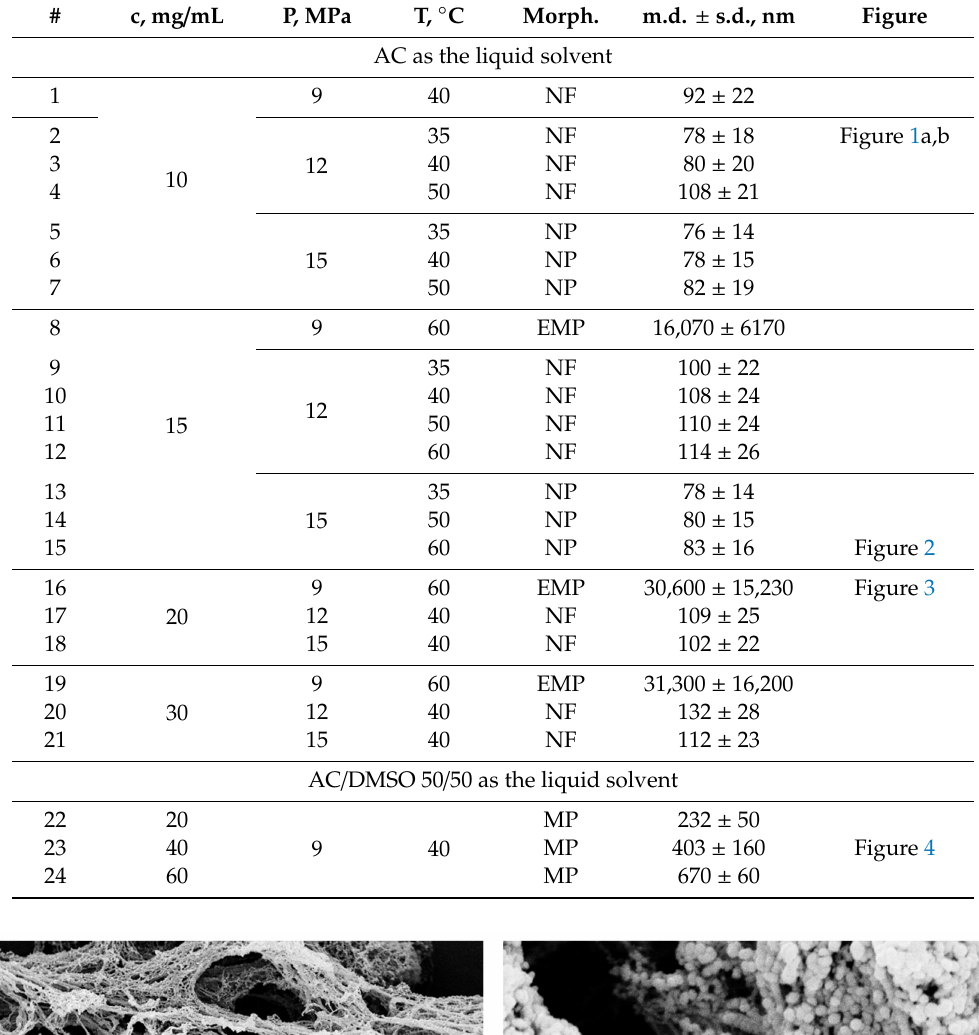
Table 1. List of the performed experiments using supercritical antisolvent precipitation. NF: